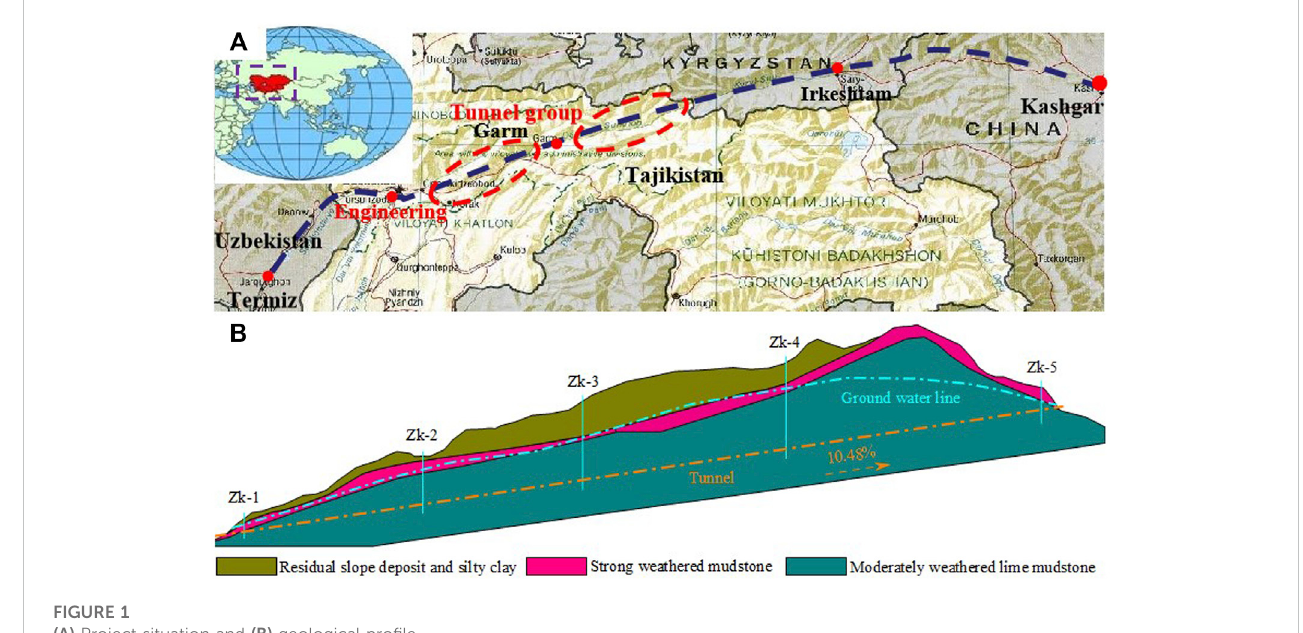
FIGURE 1 (A) Project situation and (B) geological pro fi le.